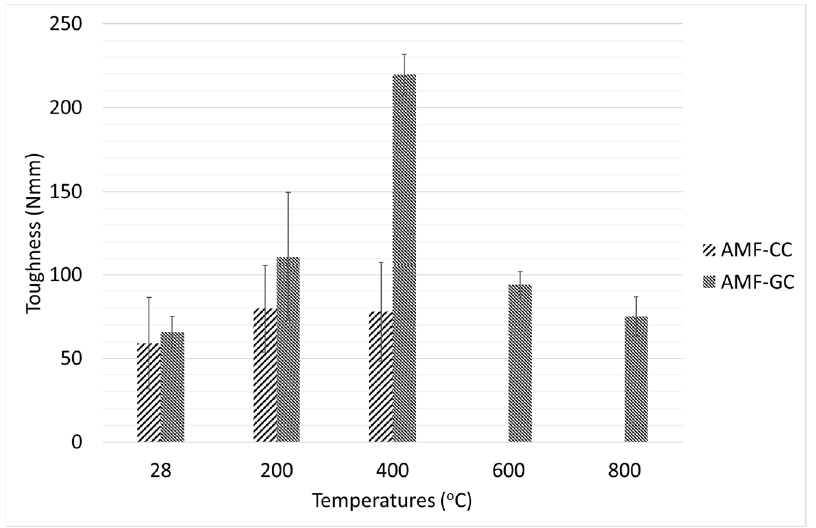
Figure 11. Toughness of AMF reinforced cement and geopolymer concrete at elevated